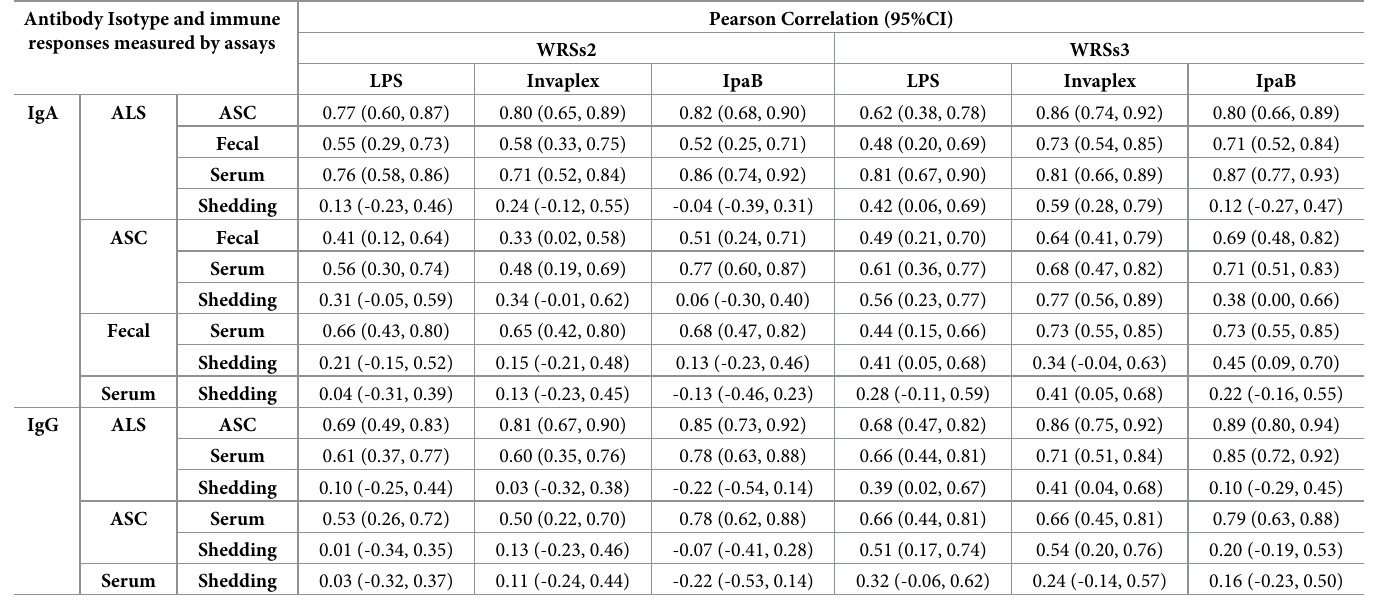
The correlation among the immune response measurements was carried out using Pearson correlation with 95% CI of the maximum log 10 transformed end-point titers in S . sonnei -antigen-specific IgA- and IgG-ALS, serum antibodies and fecal IgA responses and S . sonnei antigen-specific peak IgA- and IgG-ASCs. Shedding is described as maximum vaccine shedding for each vaccinee in CFU/gm of